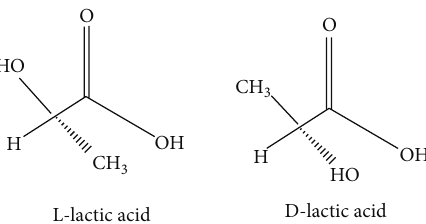
Figure 1: Optical forms of lactate: L(+) and D( − ) lactate. The sign ( − ) is because the molecule makes polarized light turn left ( levorotatorylacticacid );theoppositeforthe(+)sign( dextrorotatory lactic acid